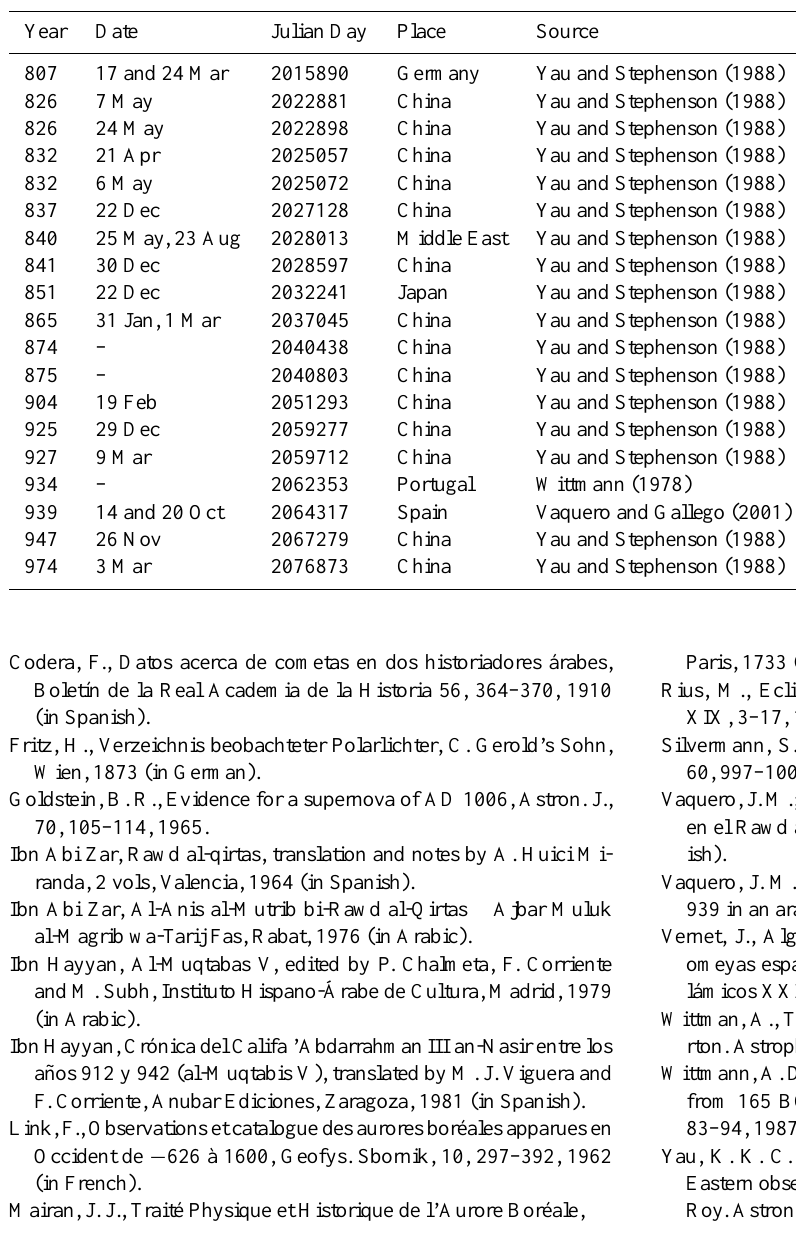
Table 4. Naked eye observable sunspots during the 9th and 10th centuries described in different